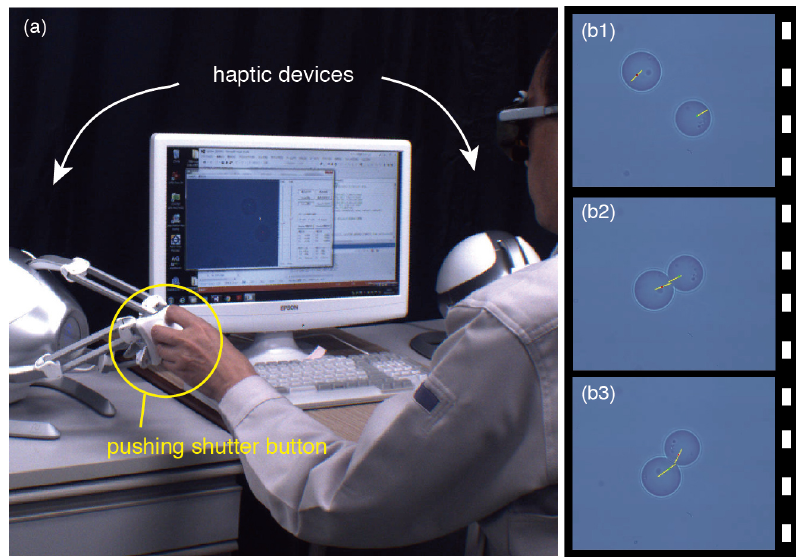
Figure 3. ( a ) Snapshot of the 3D position control of end-effectors (two 7.8 µ m glass microbeads) through two haptic devices. ( b ) Video frame sequence of the simultaneous handling of the two microbeads. The tweezing beam positions controlled using the haptic devices are superimposed by the green and red circles. The forces generated by the contact or viscous drag are also superimposed in real time at the point of action by the yellow lines. The images are also shown in Supplementary Videos S1 and